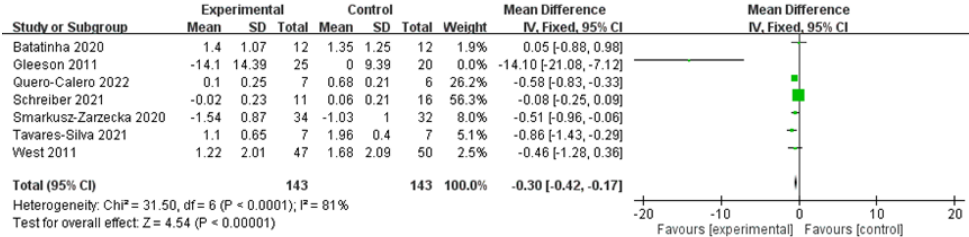
Figure 2. Flowchart of the risk of bias domains.